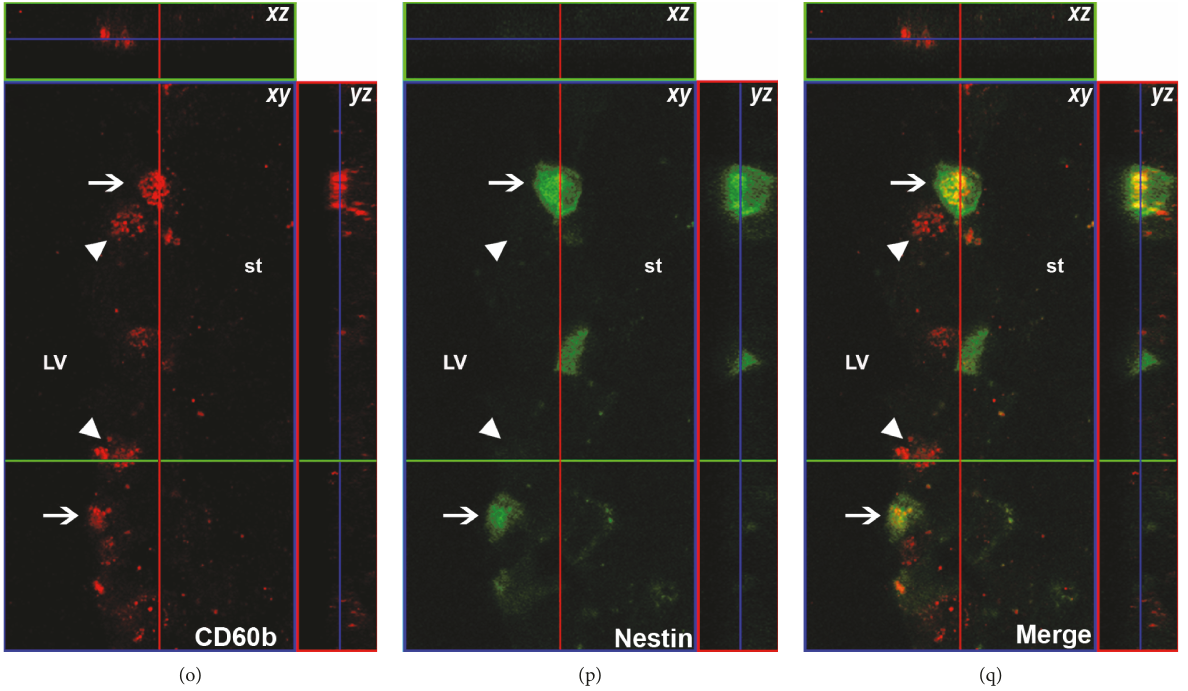
Figure 3: CD60b is expressed along rat adult subventricular zone in proliferative and stem/progenitor cells. (a) Confocal image of a coronal section of the lateral ventricle of adult rat showing expression of CD60b in red. We can note cells expressing CD60b antigens in the lateral wall near the RMS (arrowheads) and cells CD60b-positive in the medial wall of the lateral ventricle (arrows). (b) High magni fi cation of the SVZ showing punctiform expression of CD60b in SVZ cells along the lateral wall. We can notice that not all the cells express CD60b. (c – n) Confocal images of cells dissociated from the subventricular zone of adult rat stained with TO-PRO-3 (in blue; c, g, and k), showing the expression of CD60b (in red; (d, h, and l)) costained for BrdU (e), GFAP (i), or nestin (m) in green. Merge images are show in (f, j, and n). (o – q) Confocal Z-stack reconstruction and orthogonal slices (superior and lateral boxes) showing cells double- labeled (arrows in q) for CD60b in red (o) and nestin in green (p). Merge images showing colocalization in (q). We can also note CD60b- positive cells that do not express nestin (arrowheads in (q)). Scale bar: 300 μ m (a); 30 μ m (b); 12 μ m (c – q). cc: corpus callosum; LV: lateral ventricle; st: striatum.